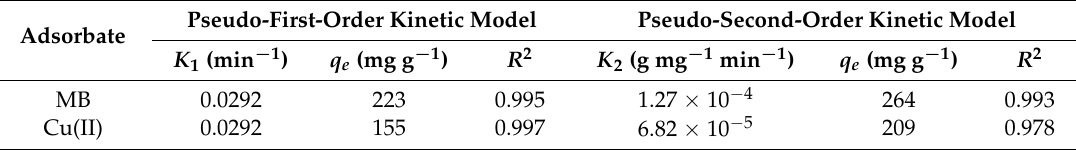
Table 1. Kinetics parameters for the adsorption of MB and